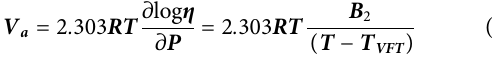
FIGURE 5 | Effect of temperature on the viscosity of K 2 Mg(CO 3 ) 2 (KM, blue) and K 2 Ca(CO 3 ) 2 (KC, orange) melts from this MD study (full circles) and comparison with literature data for alkali and alkaline carbonate melts. All data are reported at 3 GPa unless indicated next to the symbols (in GPa). Solid lines represent fi ts to the temperature dependence of the viscosity data by the VFT model (present data) and dashed lines by an Arrhenian model (literature data). Errors bars on KM, KC and K 2 CO 3 melts from Dobson et al. (1996) correspond to 50% (not shown for the sake of clarity). Viscosities of silicate melts are indicated for comparison (Giordano et al., 2008).